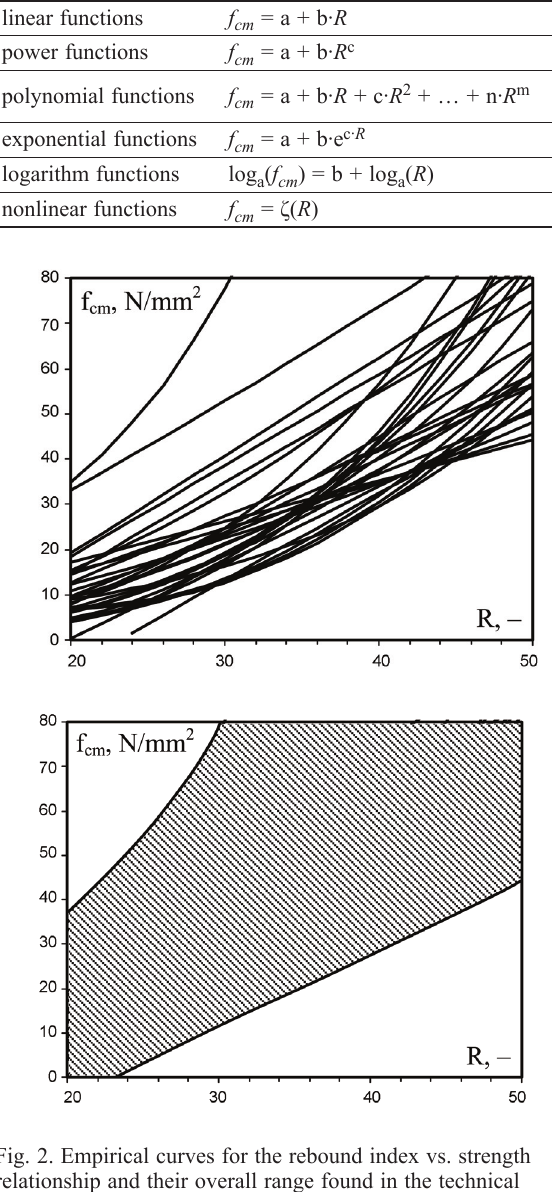
Fig. 2. Empirical curves for the rebound index vs. strength relationship and their overall range found in the technical literature (Szilágyi et al .